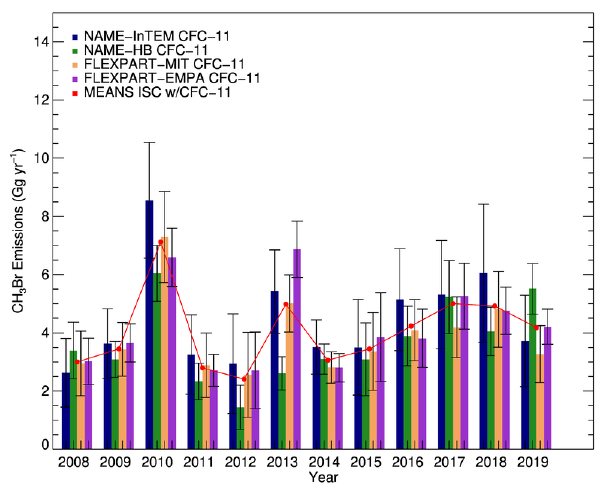
Figure 8. CH 3 Br emission estimates derived for eastern China by ISC from the observation data of CH 3 Br and CFC-11 at Gosan during 2008–2019. CFC-11 emissions were taken from Park et al. (2021) and are estimated using four independent inverse model frameworks (NAME-HB, NAME-InTEM, FLEXPART-MIT, and FLEXPART-Empa). The bar plot of each color denotes the emis- sions of CH 3 Br with 1 σ uncertainty derived from each inversion of CFC-11, and the average of the four different inversions is shown in red.